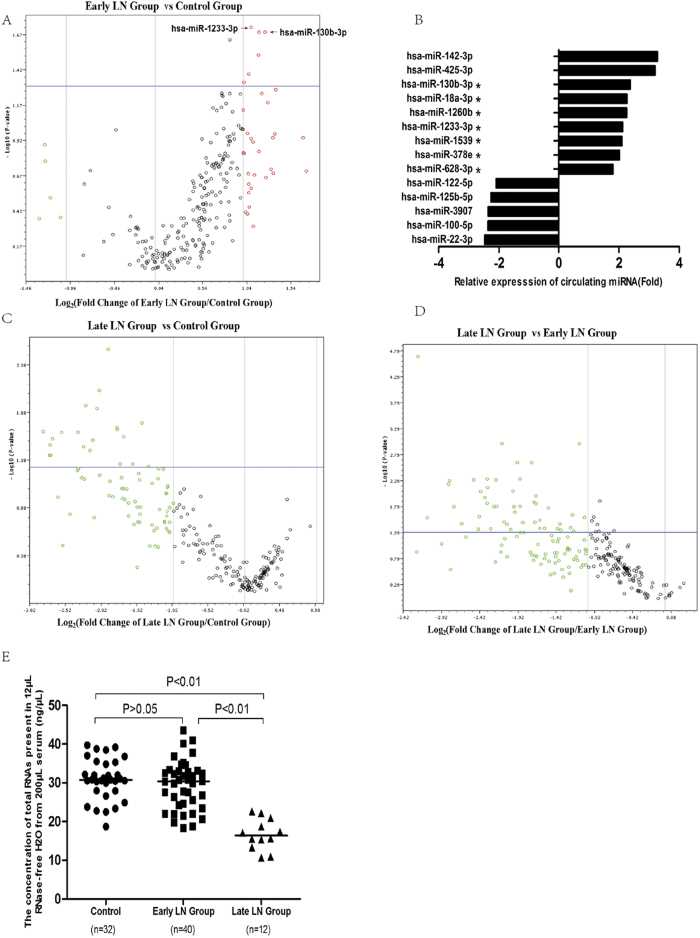
erum miRNA expression in patients with lupus nephritis (LN).(A) Serum miRNAs profile from 4 early stage LN patients (eGFR > 30 mL/min/1.73 cm2) versus 4 healthy controls. (B) The fold of serum miRNA changes of early stage LN versus healthy controls. (C) SerummiRNAsprofile from 4 late stage LN patients (eGFR < 30 mL/min/1.73 cm2, CKD 4–5 stage) versus 4 healthy controls. (D) SerummiRNAs profile from 4 late stage versus 4 early stage LN patients. (E) The concentration of total RNAs present in 12 μL Rnase water from 200 μL serum of the validation group. The vertical line represented the changing fold equal to –2 (down-regulation), 1, 2 (up-regulation and invisible in Fig. 1D). The plots above the horizontal line represent the miRNAs with P values less than 0.05. *P < 0.05 **P < 0.01.